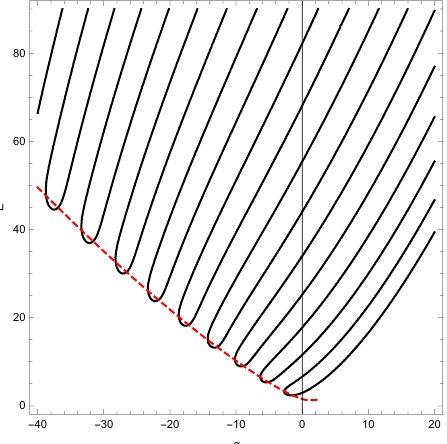
Figure 3 . The black lines show the values of ( (cid:11); E ) in the spectrum of (3.21) at ~ = 1. The dashed red line is the solution of the equation (3.45), which de(cid:12)nes the boundary between the phases of broken and unbroken PT